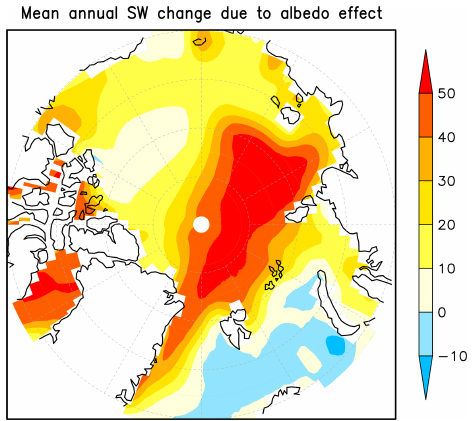
Figure 4. Spatial distributions of the Pliocene annual mean net shortwave flux change (Wm − 2 , positive downward) at the surface over the Arctic Ocean caused by the albedo effect of sea ice change with respect to the pre-industrial period.